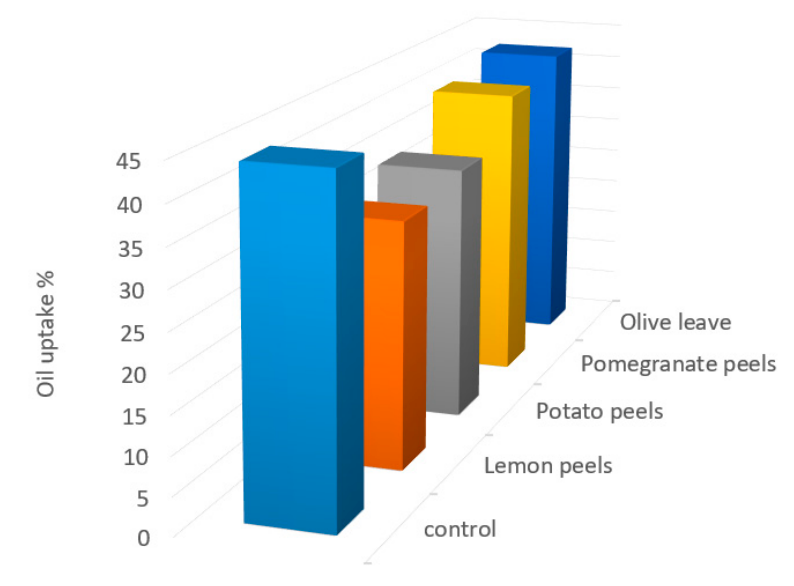
Figure 3. The oil uptake content (%) in control and treated potatoes fried with different agro-indus- trial